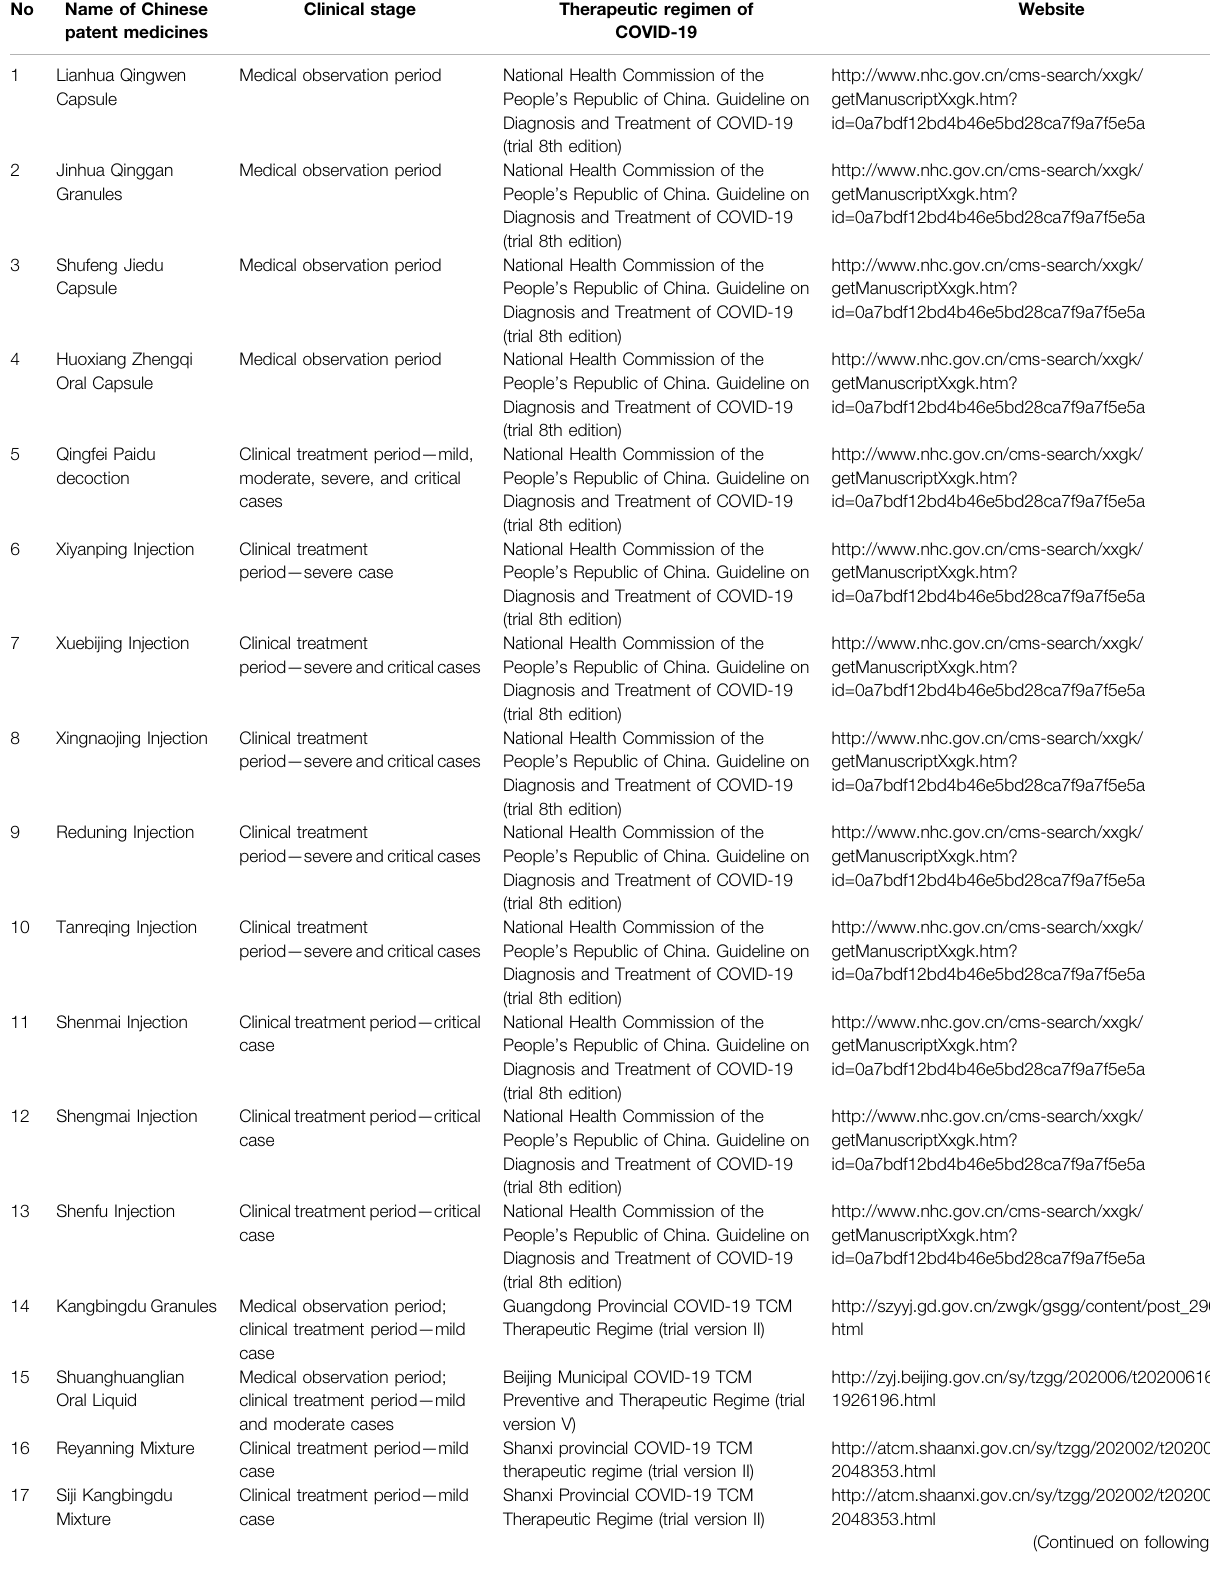
TABLE 1 | Therapeutic regimens of recommended CPMs for COVID-19 in